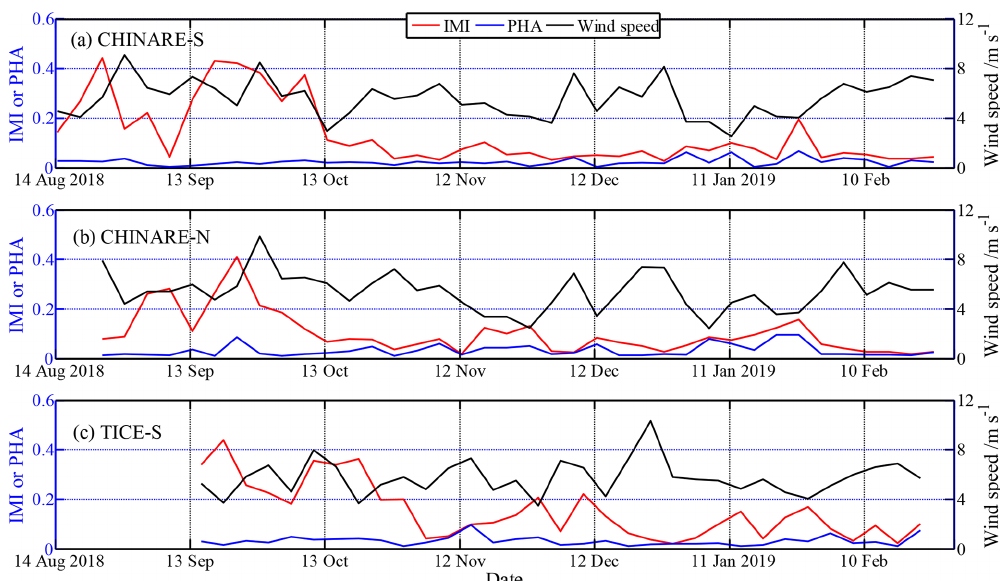
Figure 10. Amplitudes after Fourier transformation of normalized ice velocity at the negative-phase inertial frequency (IMI) and positive- phase semidiurnal frequency (PHA) obtained from the 5d temporal window, as well as the corresponding wind